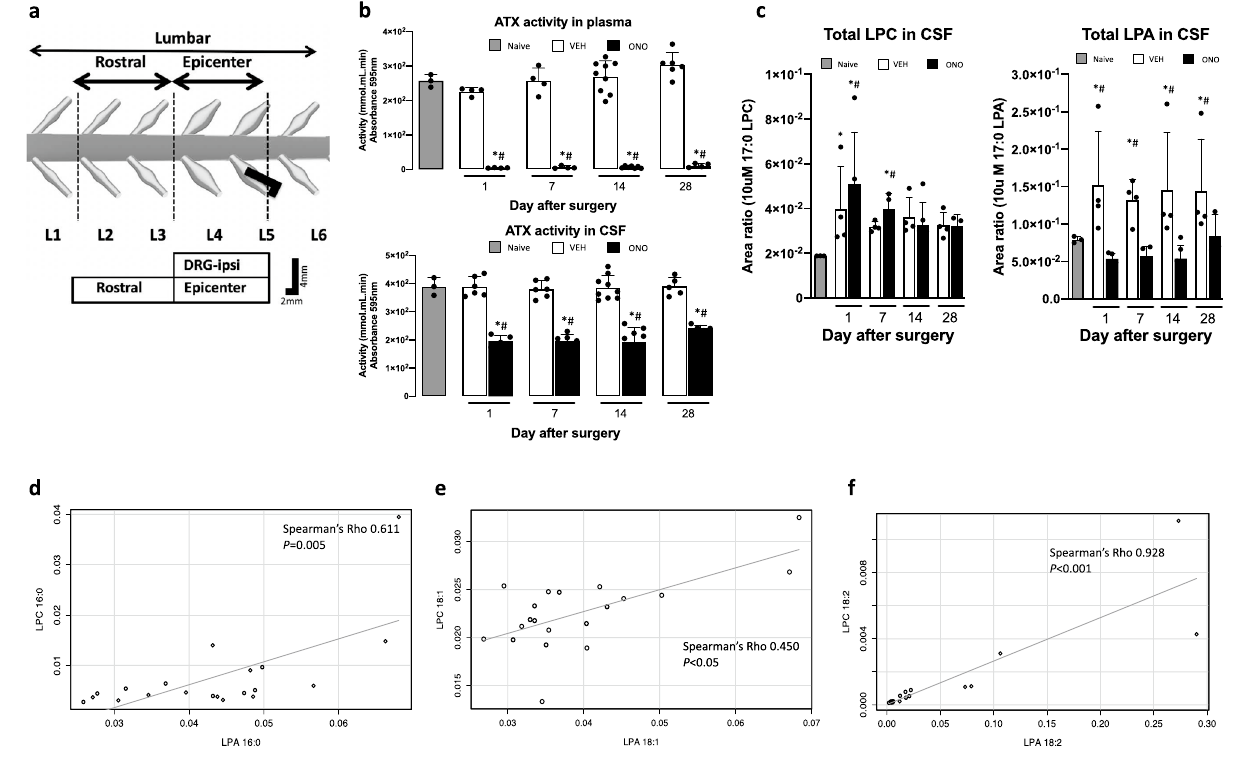
Figure 1. The CD model scheme and effect of the ATX inhibitor on production of the LPA in ONO group and corresponding correlations between LPC and LPA species in VEH group. ( a ) Schema of the CD model describing position and shape of the inserted stainless rod with tissue sampling information. ( b ) ATX activity measured in plasma (upper) and CSF (lower) of the naive, VEH and ONO groups at selected time points. ATX activity inhibited fully in plasma samples, whereas half of the activity remained in CSF of the ONO group at all selected time points. ( c ) Influence of the ATX inhibitor to the total LPC (left) and LPA levels (right) in CSF. LPC levels were increased in both group in day 1 and it was even more increased in the ONO group than VEH group showing interruption of the LPA biosynthesis from LPC. In the VEH group, LPA levels were significantly increased comparing with the ONO group at all the points. Values represent the mean ± SD (n = 5). Symbols indicate significant differences between groups analyzed by one-way ANOVA and paired t-test as follows: VEH, ONO groups with naive: p < 0.05*. VEH, ONO groups between each other at each selected time points: p < 0.05 # . ( d ) Representative data of the correlation of the corresponding LPC and LPA species for the VEH group in CSF. LPC 16:0, 18:1, 18:2 was correlated with corresponding LPA 16:0, 18:1, 18:2 with Spearman Rho 0.611 (p = 0.005), 0.450 (p < 0.05) and 0.928 (p < 0.001) respectively. Values represent the mean ± SD (n =